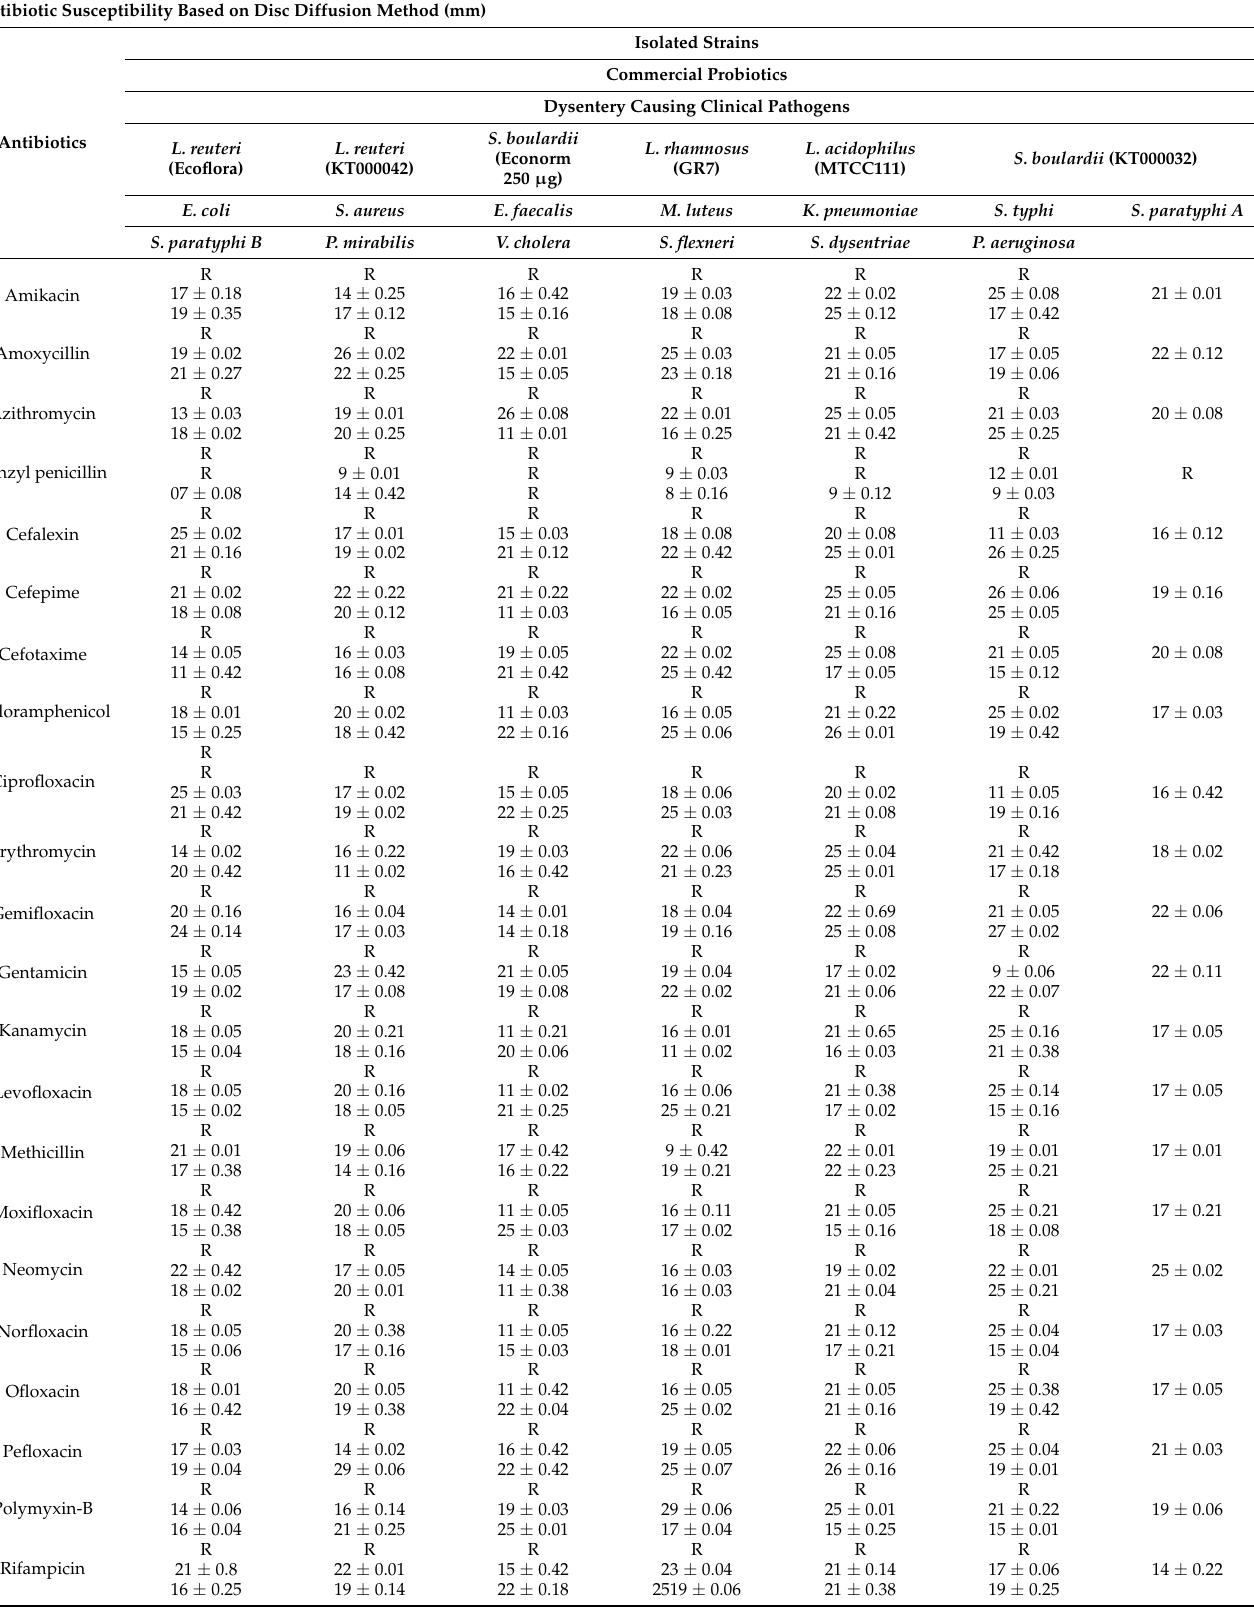
Table 7. Antibiotic susceptibility (mm) of Saccharomyces boulardii strains CFS against commercial probiotics and clini- cal